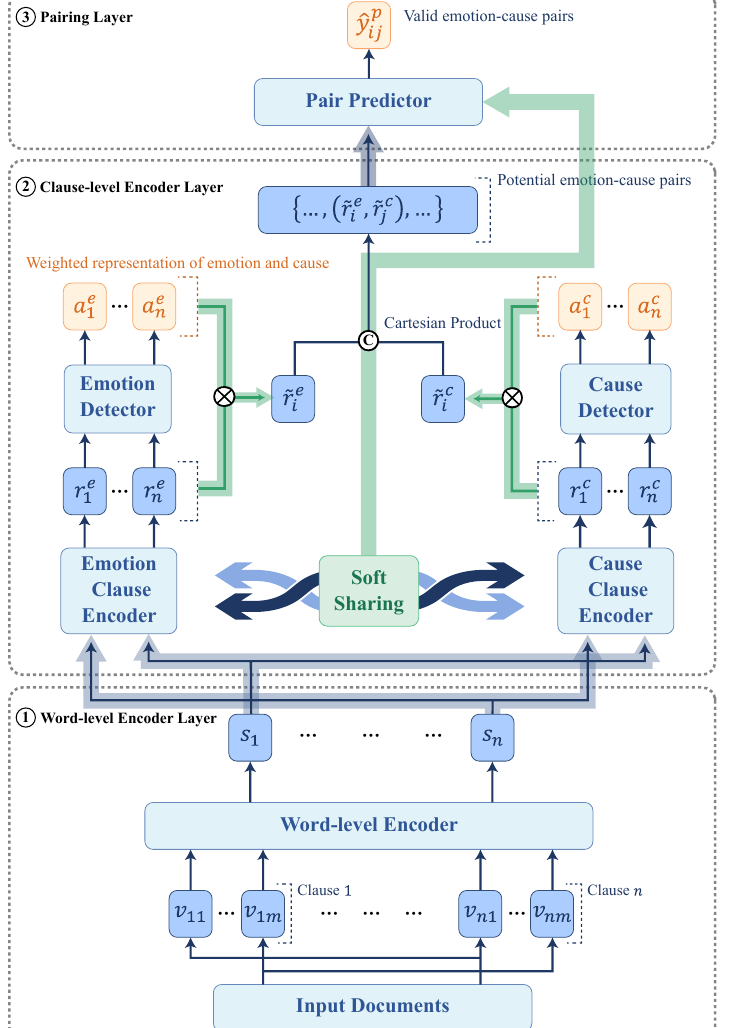
Figure 2. An illustration of our proposed end-to-end mutually interactive emotion–cause pair extrac- tor. v 11 , v 1 m , v n 1 and v nm denote the word vector sequence. s 1 and s n are the clause representation as the output of the word-level encoder. Additionally, r e representation of corresponding clauses. a e the clause being an emotion clause and a cause clause. ˜ r e cause-weighted clause representations, respectively. ( ˜ r e ˆ y p gives the Bernoulli distribution probabilities of potential emotion–cause pairs to be ij